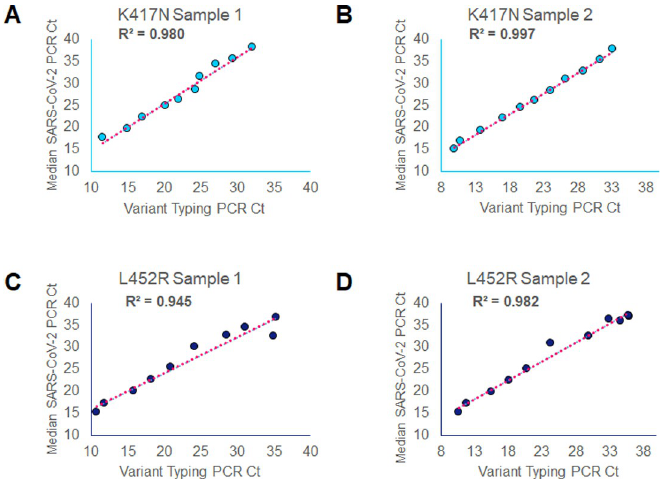
Fig 3. Correlation between variant typing and median SARS-CoV-2 PCR Ct values. Variant II PCR Cts (x-axes) and SARS-CoV-2 PCR median Cts (y-axes) of 2 different K417N (A and B) and 2 different L452R (C and D) 5-fold serial diluted